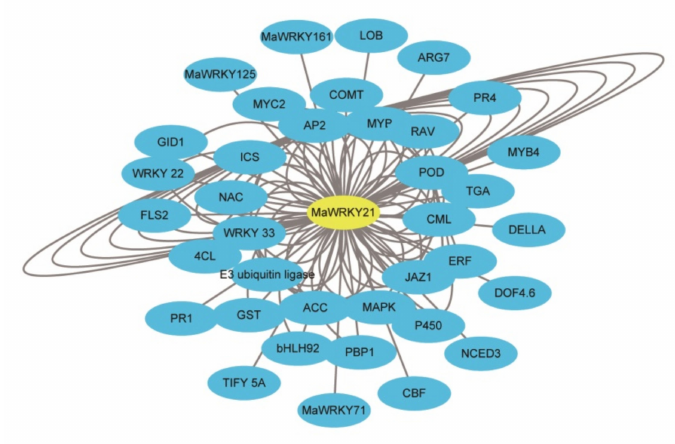
Figure 8. The interactive networks of MaWRKY21 using